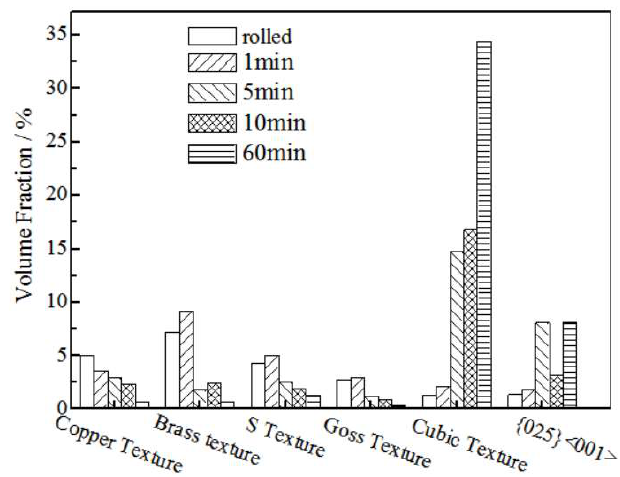
Figure 9. The textures’ fraction of the rolled and annealed copper foil.